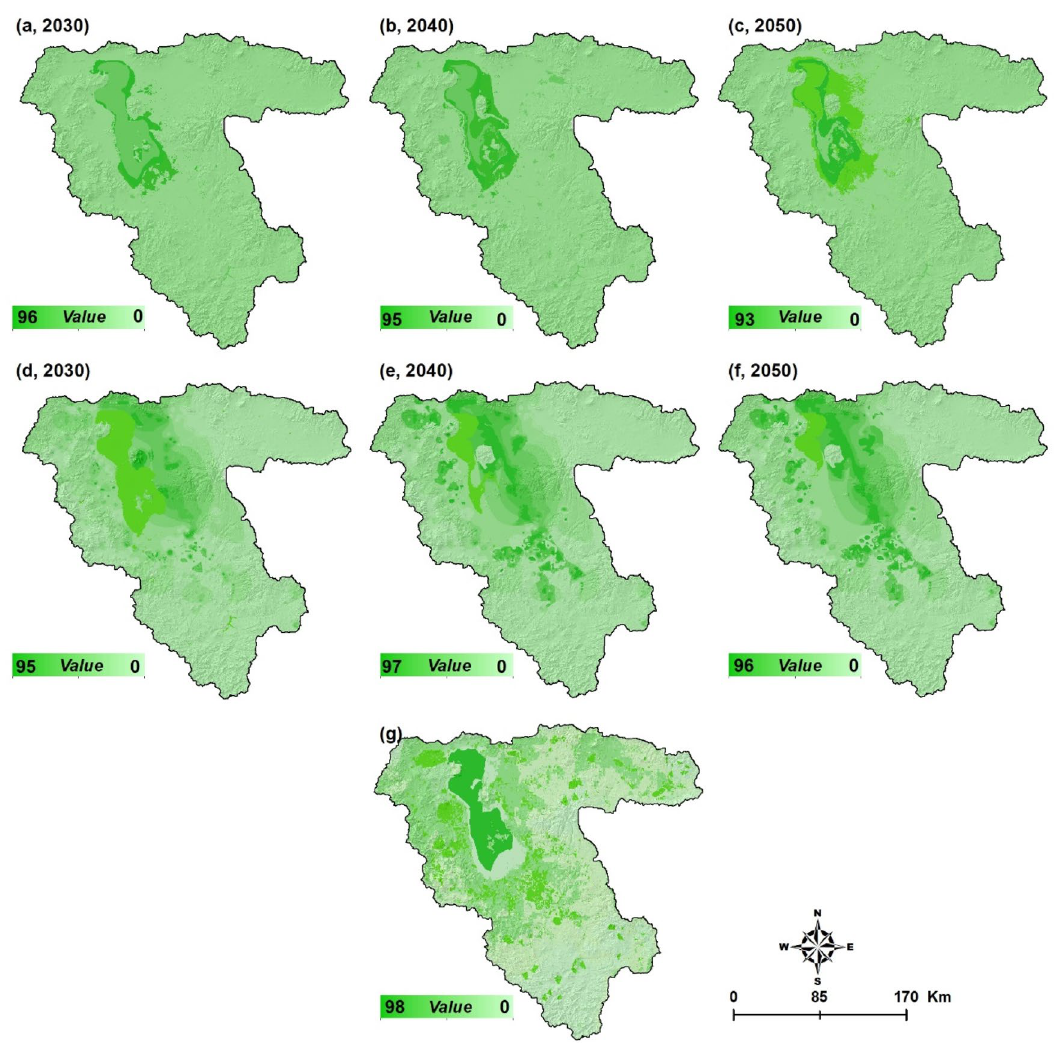
Figure 8. Results of the spatial uncertainty analysis based on the DST for the predicted soil salinization ( a – c ) and groundwater salinization ( d – f ), and the food production degree map that was generated based on the CA-Markov method ( g ). The values from 0 to 100 show the confidence level and the reliability of results based on the DST technique. Figure created in Arc GIS 10.7 ESRI, https:// www. esri.